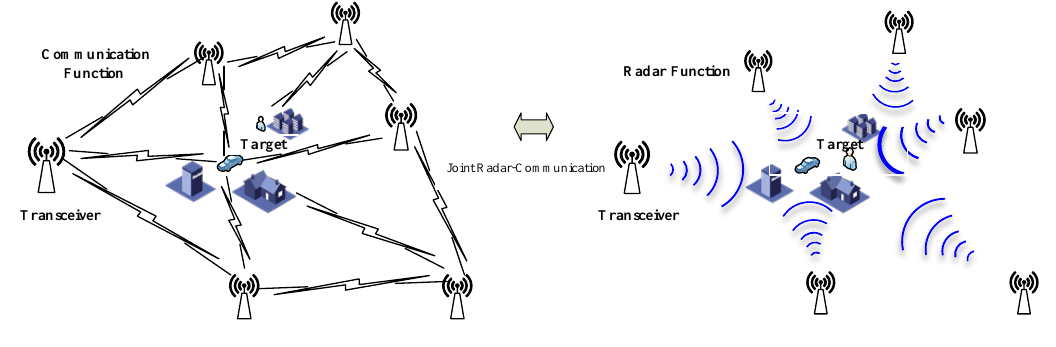
Figure 2. The joint communication-radar operation.